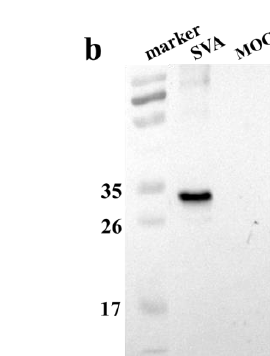
Figure 2. Identification of VP3 monoclonal antibody; ( a ) Characterization of mAb by Western blotting. The VP3 proteins expressed in E. coli BL21(DE3) were collected for SDS-PAGE, and the VP2 protein expressed in E. coli BL21(DE3) was used as a control group. ( b ) Immunoprecipitation of VP3 protein in the SVA-infected ST-R cells. The mAb 3E9 was used as the primary antibody, and the horseradish-peroxidase-labeled goat anti-mouse IgG antibody was used as a secondary antibody.